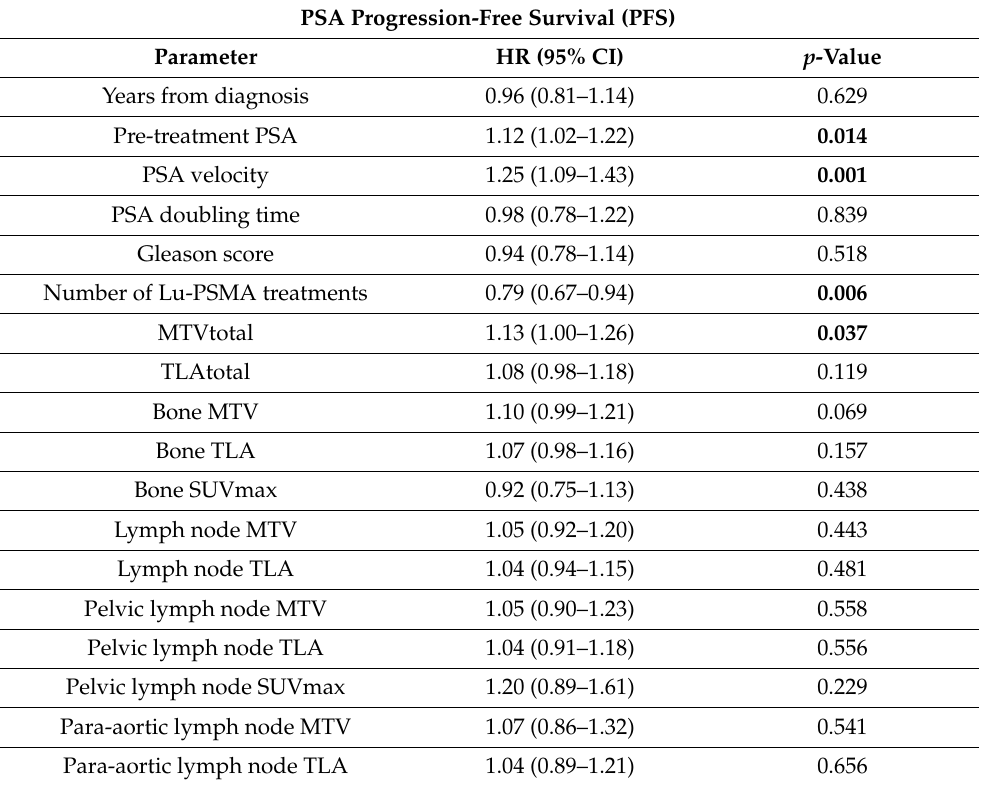
Table 4. Possible predictors for PSA progression-free survival (PFS). MTV = Metastatic tumor volume, TLA = Total lesion activity (meanSUV*tumor